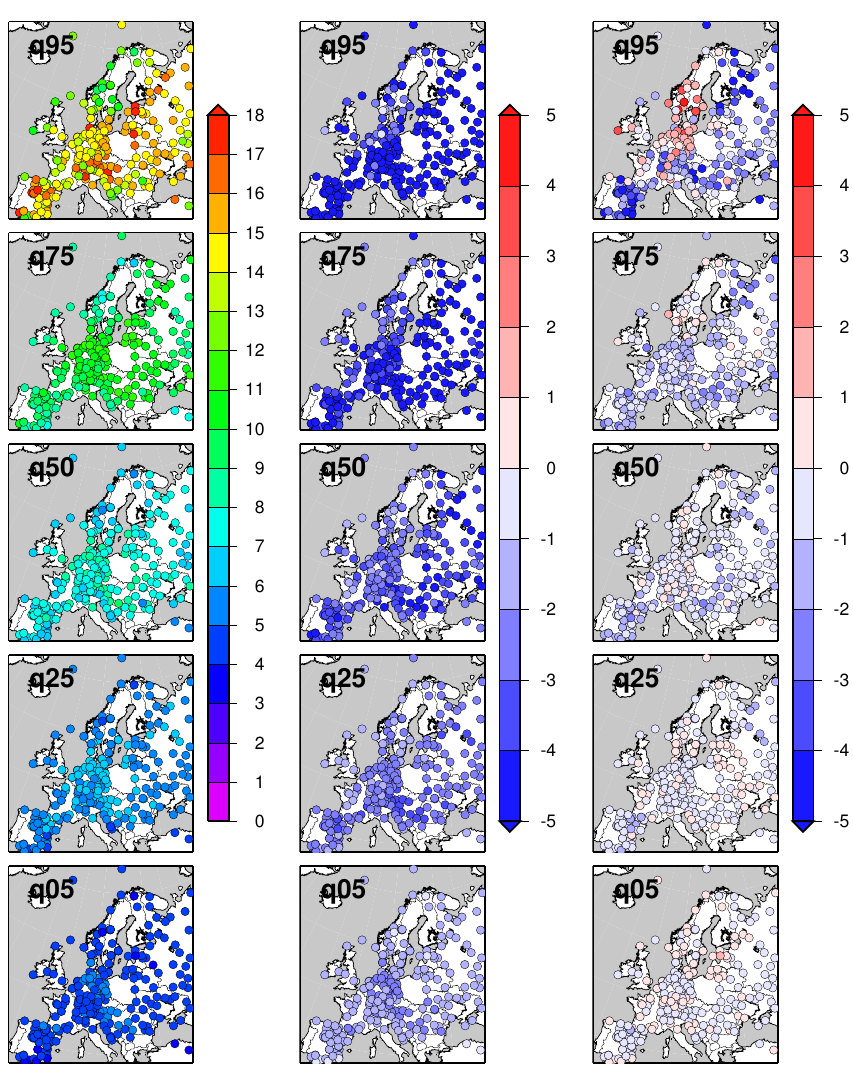
Fig. 8. Left column: 5th, 25th, 50th, 75th and 95th quantiles of winter τ (first non-positive autocorrelation lag) in ECA&D observations (in days). Central column: differences of quantiles of τ between observed and simulated temperature anomalies with “static” weather generator. Right column: differences of quantiles of τ between observed and simulated temperature anomalies with “dynamic” weather